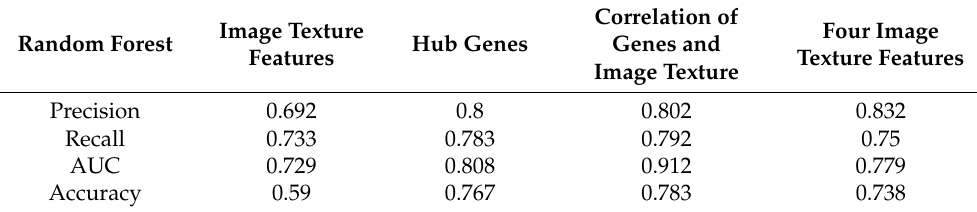
Table 2. Precision, recall, AUC, and accuracy values of predictive models created using proliferation- related hub genes and image texture features expressed using the random forest